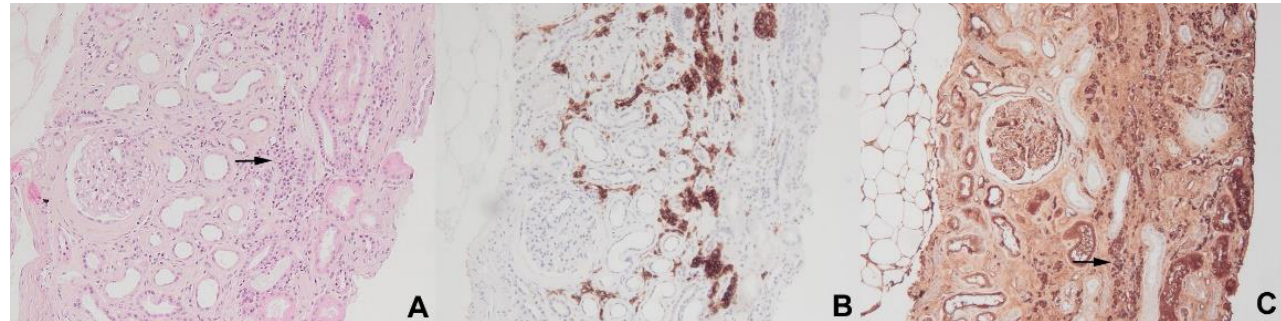
Figure 5. Monotypic plasma cell interstitial nephritis in a patient with multiple myeloma. Numerous interstitial plasma cells (( A ), hematein eosin saffron ×100, arrow) with strong staining for CD38 (( B ), ×100) and monotypic staining for kappa light chain (( C ) ×100, arrow).